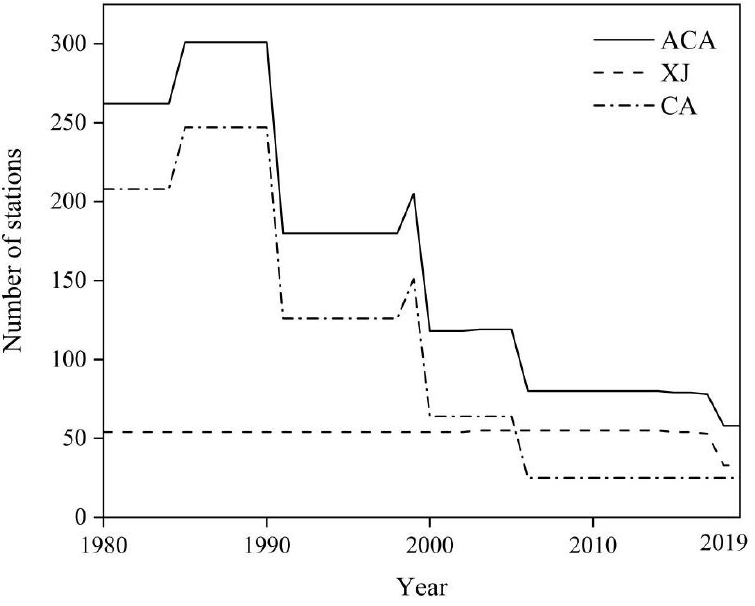
Figure 2. Changes in the number of meteorological stations in each region during 1980 – 2019.